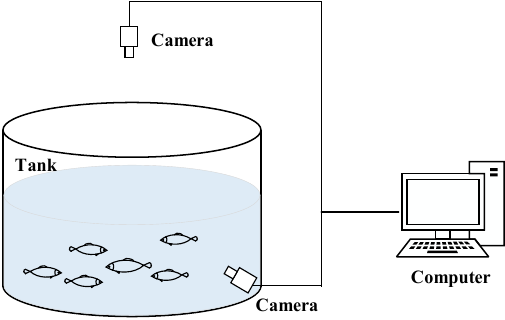
Figure 2. A typical on-site data acquisition